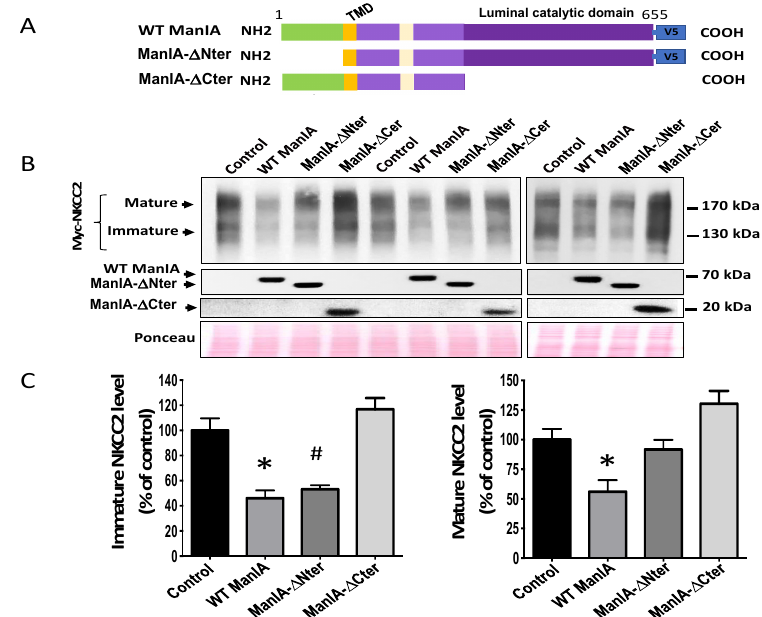
Figure 9. Role of the catalytic domain of ManIA on its effect on NKCC2. ( A ) schematic presentation of full-length WT ManIA-V5 and the truncated version of the protein devoid of its N-terminal cyto- plasmic region (ManIA- ∆ Nter) or its luminal catalytic domain (ManIA-Cter). TMD, transmembrane